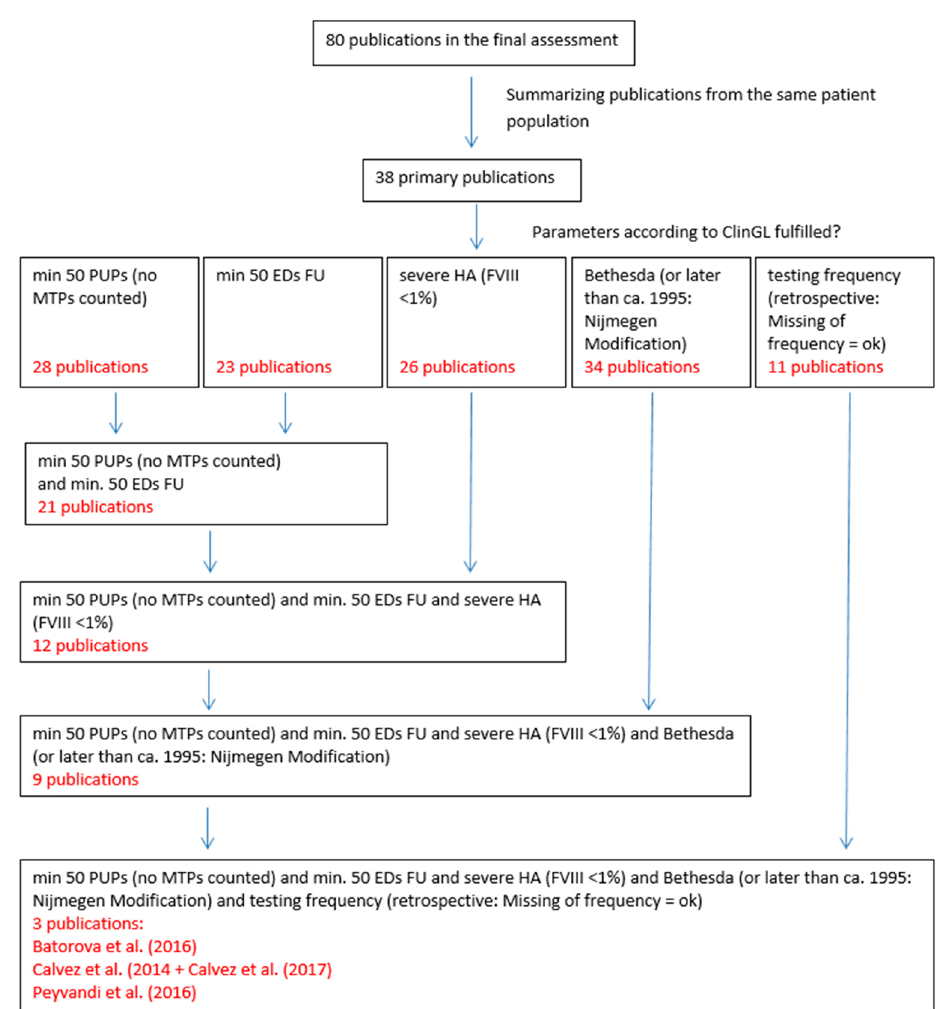
Figure 3. Relevant publications according to the parameters demanded in the ClinGL. A table of these 80 publications and the assessment process can be found in the Supplement to this paper (File S2).